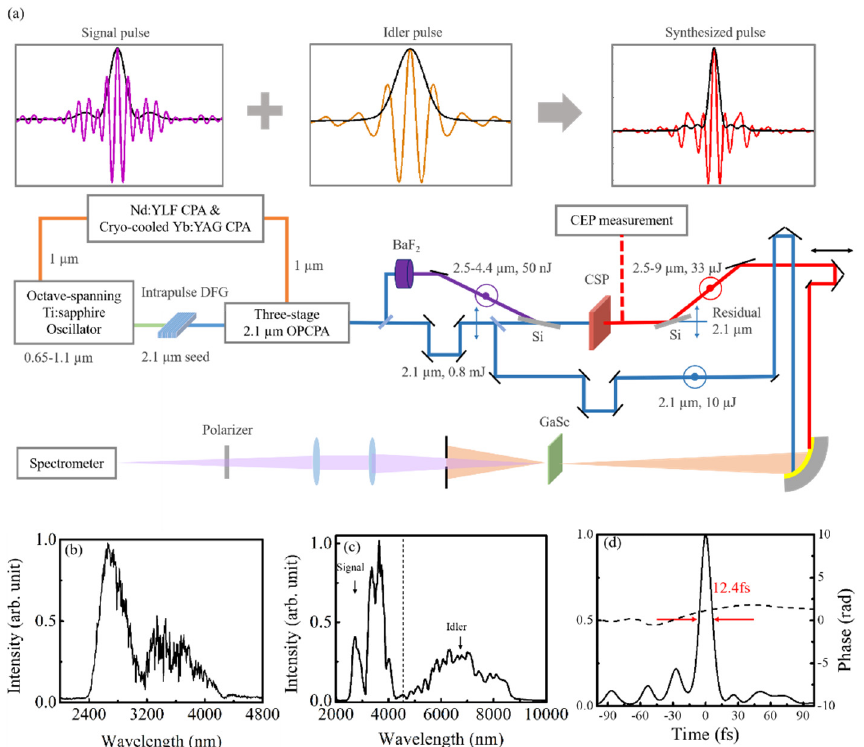
and above 10 μ m (light blue line) needed different delays to be generated because of the uncompressed seed pulse. With type I phase matching, a maximal MIR power of 1.0 W could be generated. Type I, however, allowed the generation of slightly more broadband spectra than type II. More information is provided in section S5. Power spectral density is pro- vided in units of mW/cm − 1 and μ W/f rep , where f rep = 37.5 MHz is the oscillator repetition rate. Reprinted with permission from [38]. Figure 4. ( a ) The schematic of the high-energy phase-stable sub-cycle MIR OPA. Polarizations of the beams are marked by double-headed arrows and concentric circles. 300- µ m thick Si wafers at Brewster angle were used as polarization beam splitter and beam combiner to transmit the 2.1- µ m pump pulse and reflected the signal and idler pulses. The synthesized pulses and a branch of 2.1- µ m reference pulses were sent into XFROG with 30- µ m thick GaSe nonlinear crystal. The synthesis of a sub-cycle MIR pulse by coherently combining the sub-2-cycle signal and idler pulses is shown conceptually at the top of the figure. ( b ) The signal spectrum from WLG at BaF 2 , measured after a 2400 nm long-pass filter. ( c ) The measured output spectrum of the MIR OPA. The dotted line separates the signal and idler spectra. The retrieved temporal ( d ) intensity profiles of the synthesized pulse. Reprinted with permission from [35].